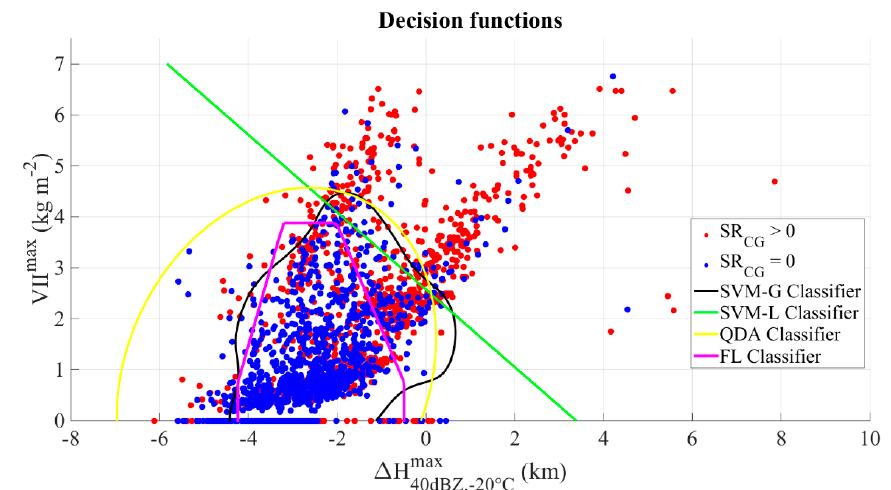
Figure 6. Scatter plot of VII max against ∆ H max 40dBZ, − 20°C for the training dataset, which includes 2580 convective cells. The SR CG > 0 and SR CG = 0 classes are highlighted as red filled-in circles and blue filled-in circles, respectively. A two-dimensional (2D) rendering of the boundary decision functions is provided, by keeping the A 40dBZ, − 10°C parameter constant to 1.0 km 2 . The yellow, black, green, and magenta curves show the quadratic classifier obtained from Quadratic Discriminant Analysis (QDA) method, the decision function determined from Support Vector Machine-Gaussian model (SVM-G) and Support Vector Machine-linear kernel function (SVM-L), and the boundary function for the fuzzy logic (FL) technique, respectively.